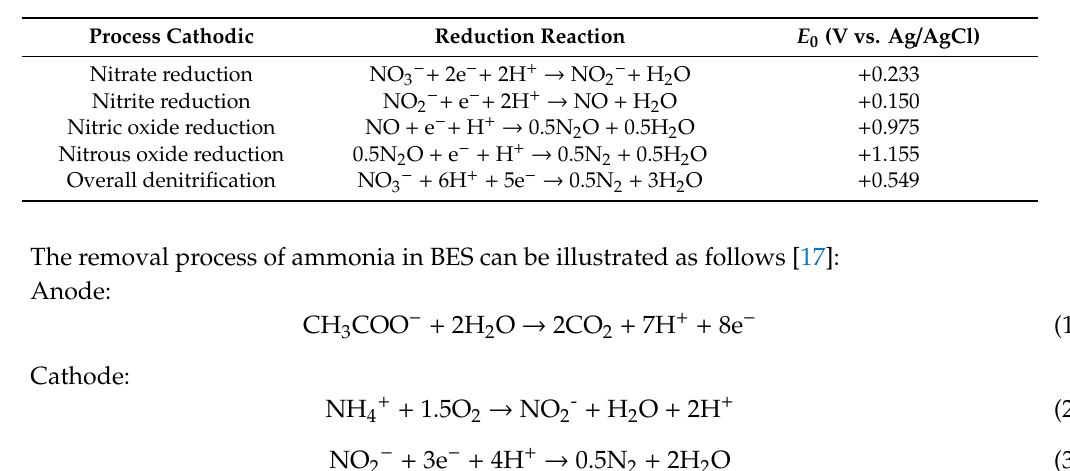
Table 1. Summary of denitrification reactions and theoretical potential